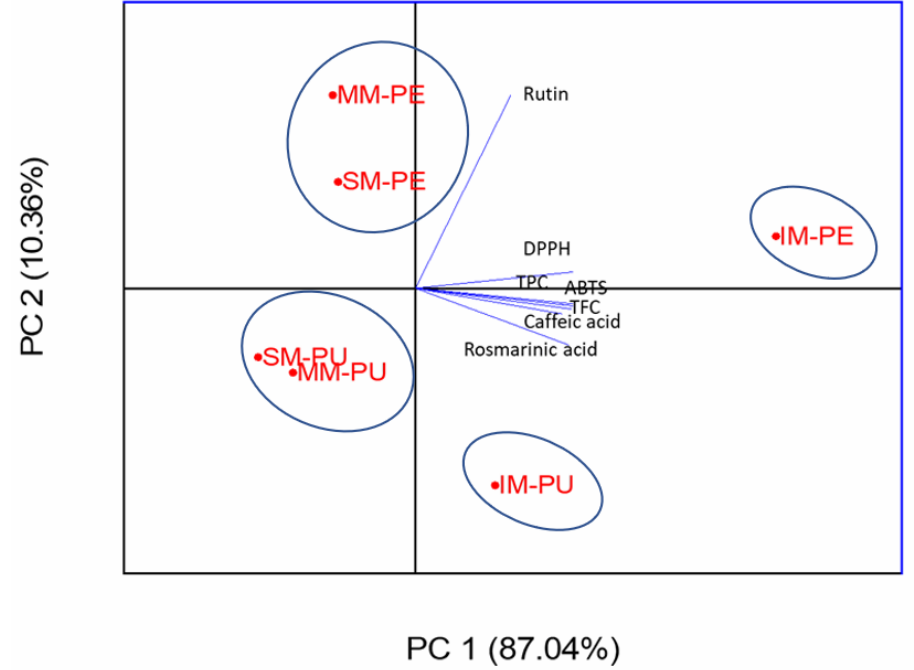
Figure 2. PCA (principal components analysis) and projection of variables TPC, TFC, antioxidant activity, and phenolic compounds with maturity stages and parts of ciricote fruit. IM: immature, SM: semimature, MM: mature; PU: pulp, PE: peel.